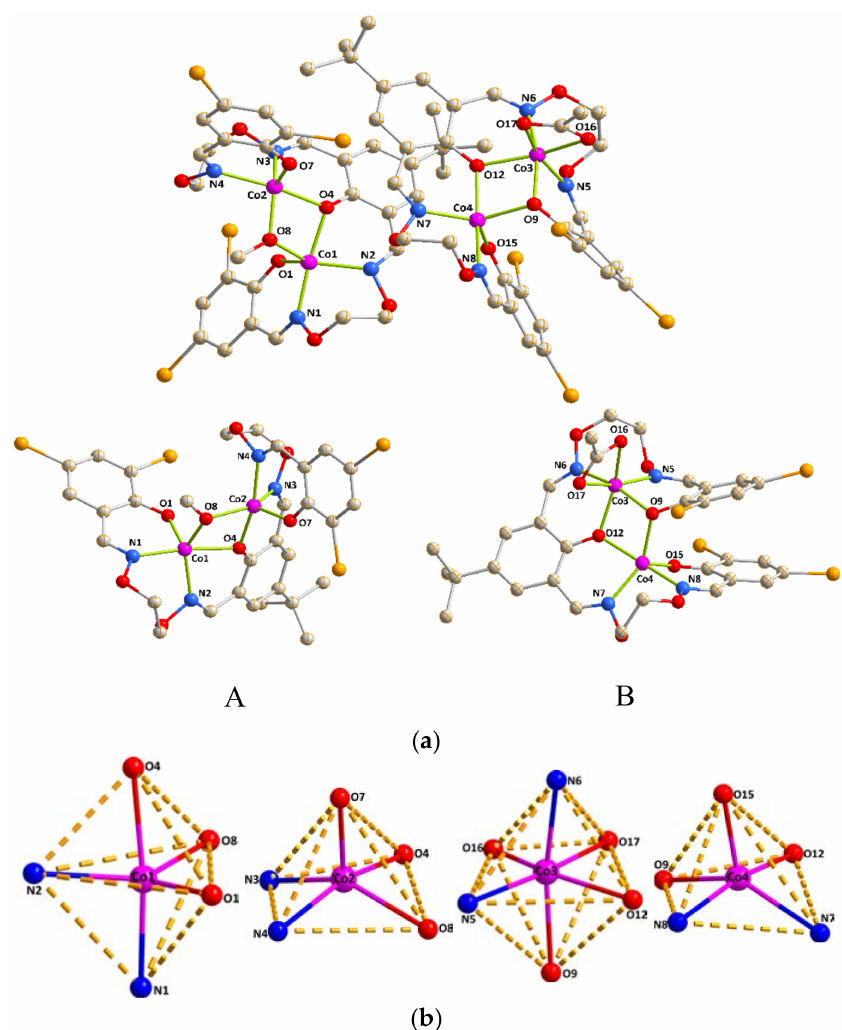
Figure 1. ( a ) Molecule structure and atom numberings of the coordination compound 1 (hydrogen atoms are omitted for clarity). ( b ) Coordination polyhedrons for Co II atoms of the coordination compound 1